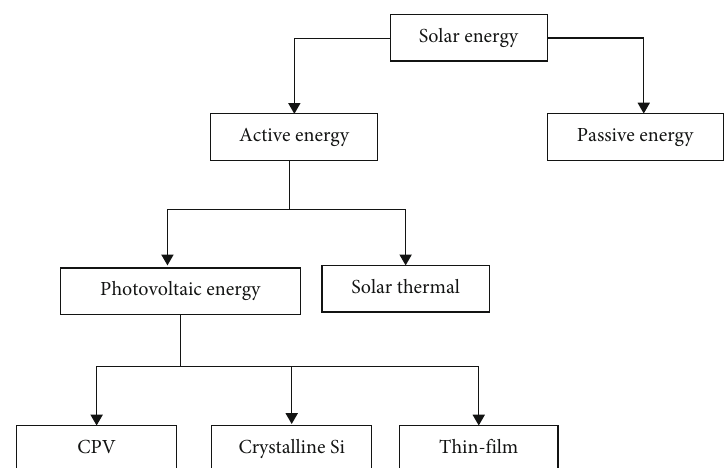
Figure 2: Classi fi cation of SPV materials [16].